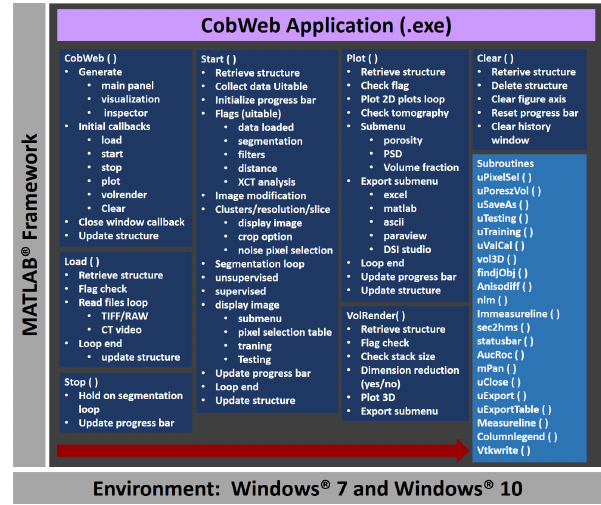
Figure 3. The general workflow of the CobWeb software tool, where the arrow denotes the series in which different modules (rep- resented in dark blue boxes) are compiled and executed. A separate file script is used to generate .dll binaries and